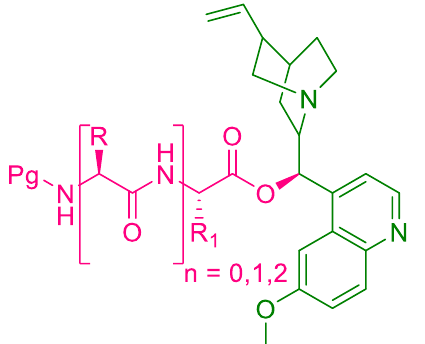
Figure 48. Amino acid conjugated to quinine.